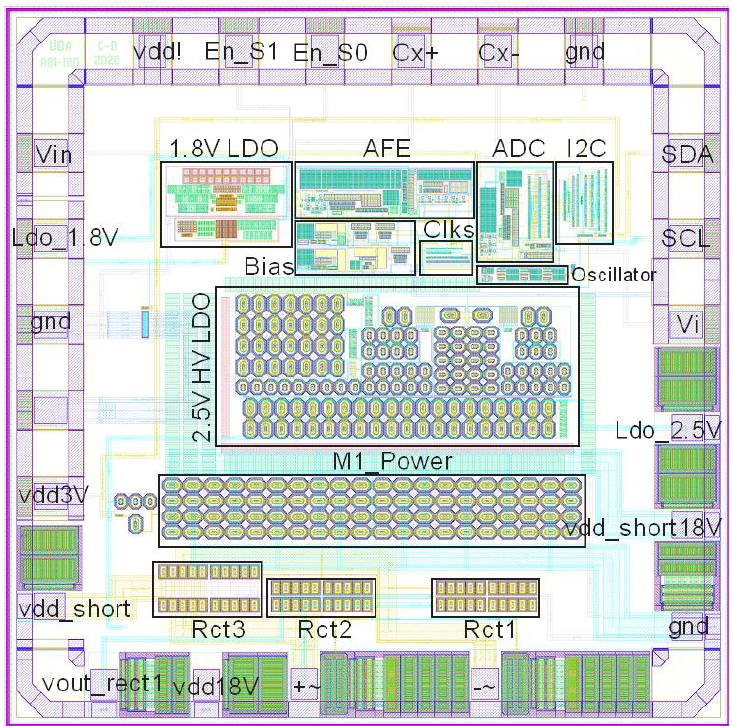
Figure 21. The ASIC (application-specific integrated circuit) layout in 180 nm technology (xh018). The total chip size is 1.5 × 1.5 mm 2 .